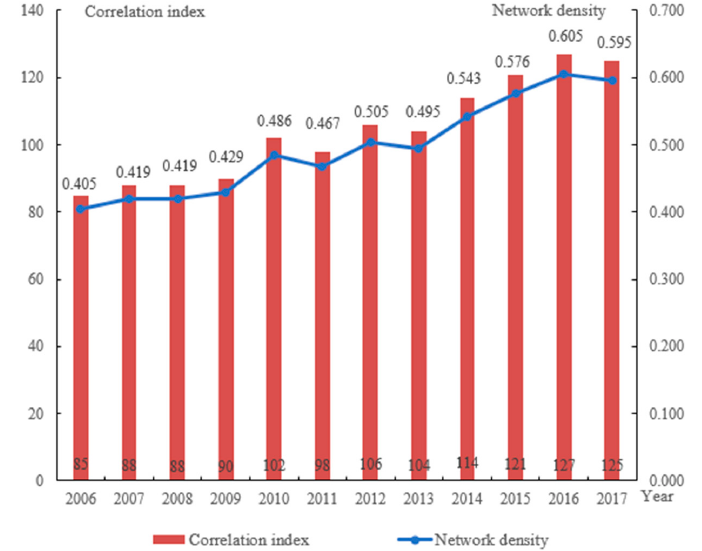
Figure 4. Correlation index and network density of water environmental governance of Yangtze River Delta in 2006–2017.